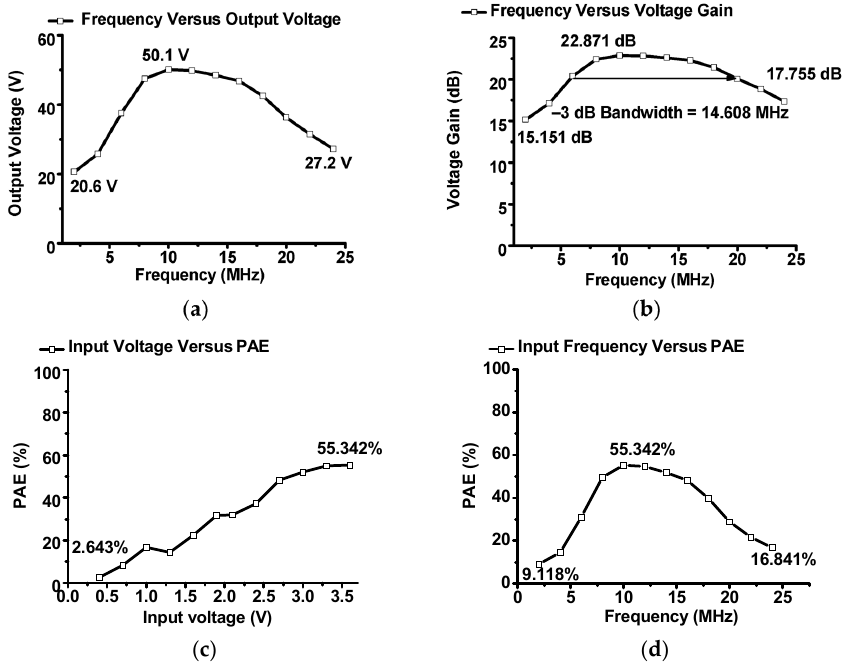
Figure 7. Measured ( a ) output voltage and ( b ) voltage gain versus input frequency, ( c ) PAE versus input voltage, and ( d ) PAE versus input frequency of the inverse Class-E power amplifier.